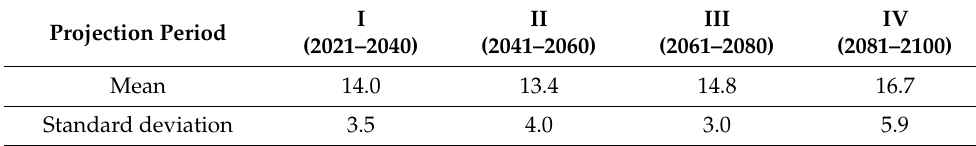
Table 7. Future runoff statistics in the Socheon SHP plant basin, [Unit: m 3 /s